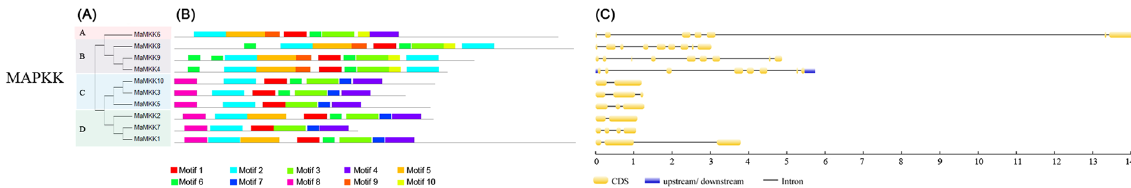
Figure 3. The phylogenetic relationship ( A ), conserved motifs ( B ) and gene structure analyses ( C ) of banana MAPKKs. All motifs were identified by MEME database. The gene structures were drawn using GSDS database. The blue boxes, yellow boxes, and the black lines indicate upstream/downstream, exons and introns, respectively.